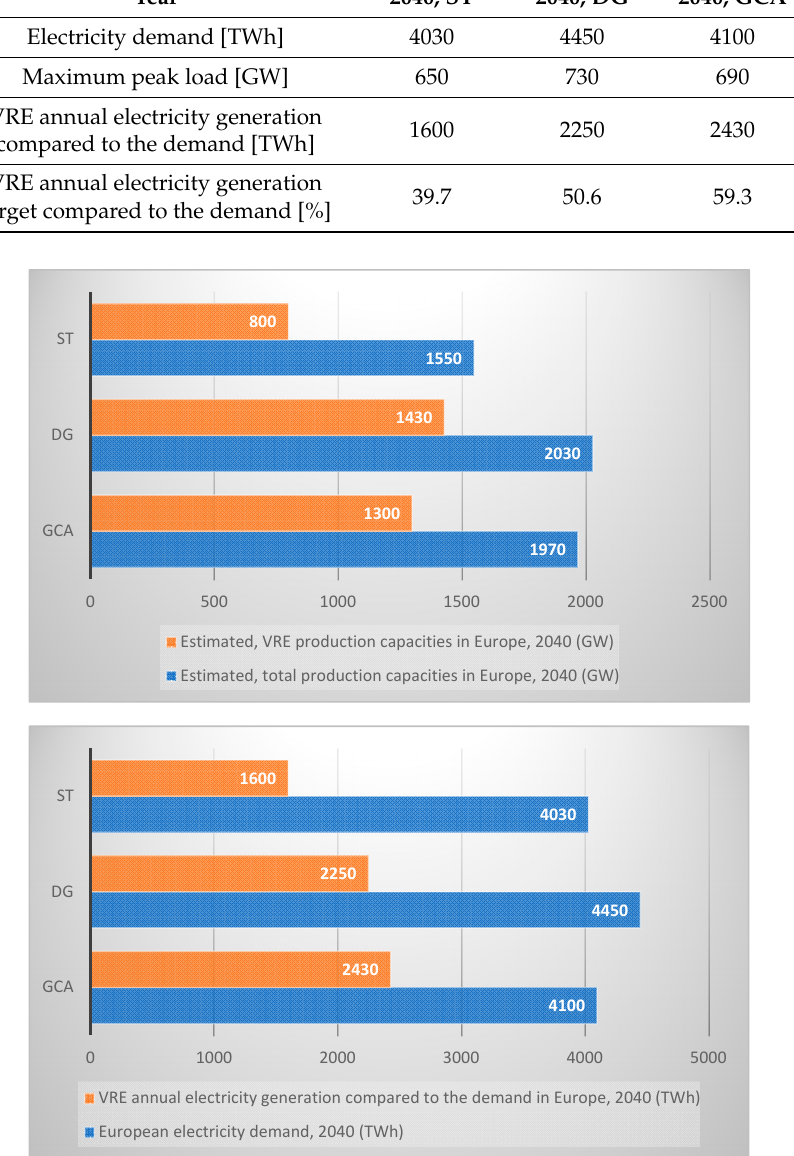
Figure 6. Installed production capacities and generation in Europe based on the 2040 scenarios [48].